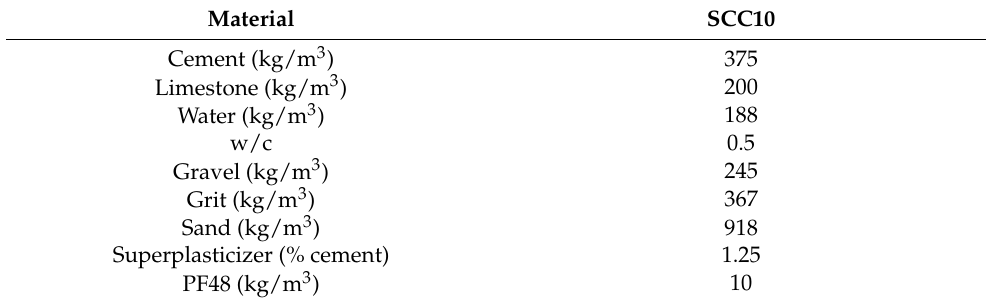
Table 1. Concrete composition.